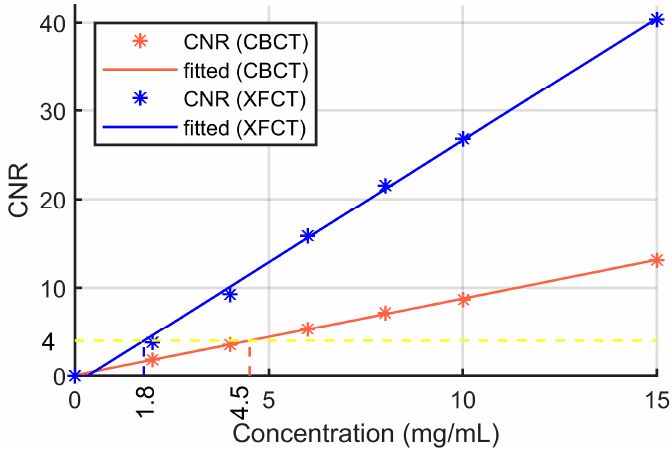
Figure 3. Contrast-to-noise ratio (CNR) of the transmission CT image and the XFCT image.